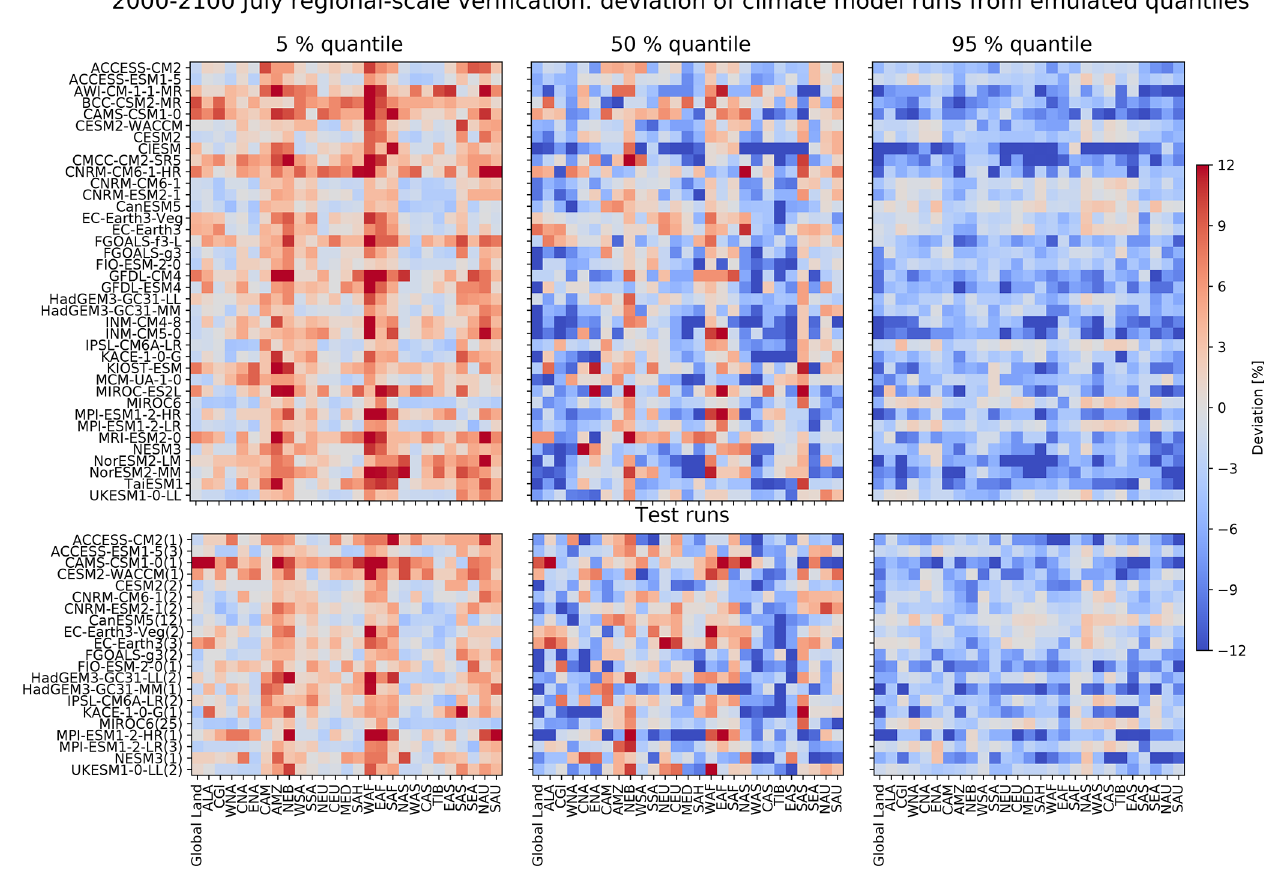
Figure 11. Same as Fig. 8, but for July over the period